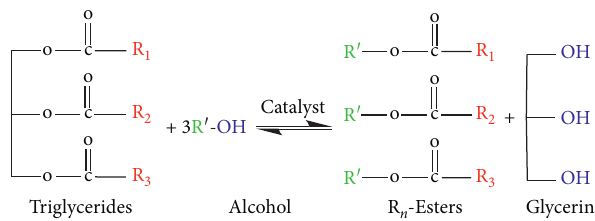
Figure 1: A typical transesterification reaction (drawn from